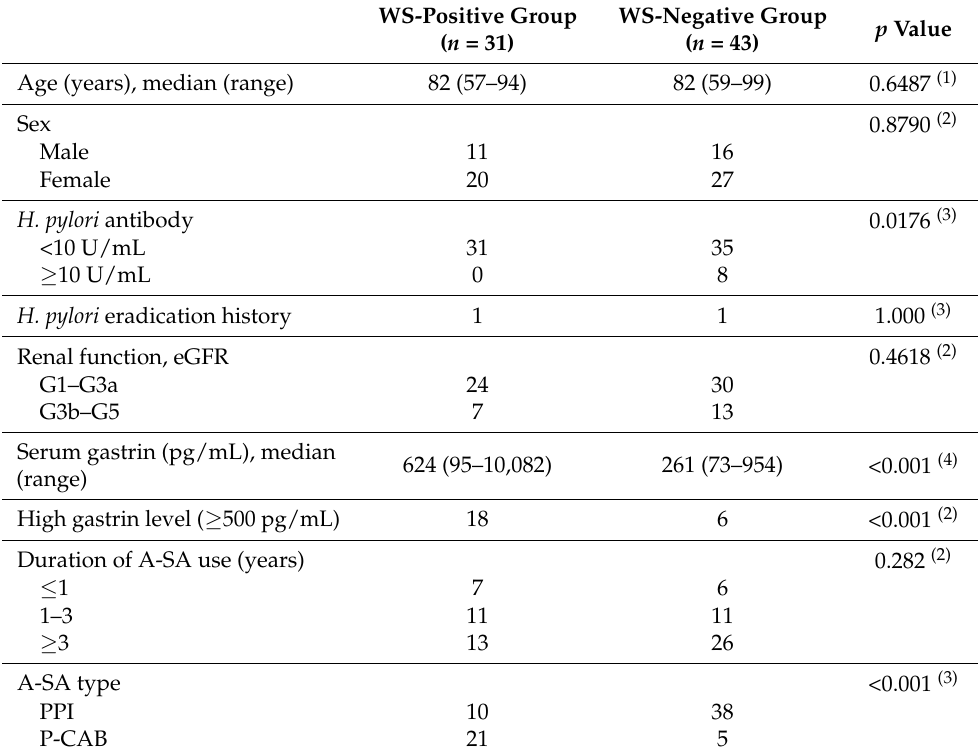
Table 3. Characteristics of the 74 patients in the WS-positive and WS-negative